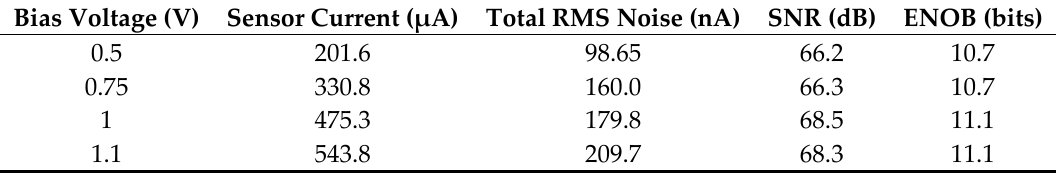
Table 1. Signal, Noise, SNR and ENOB values for each bias voltage in